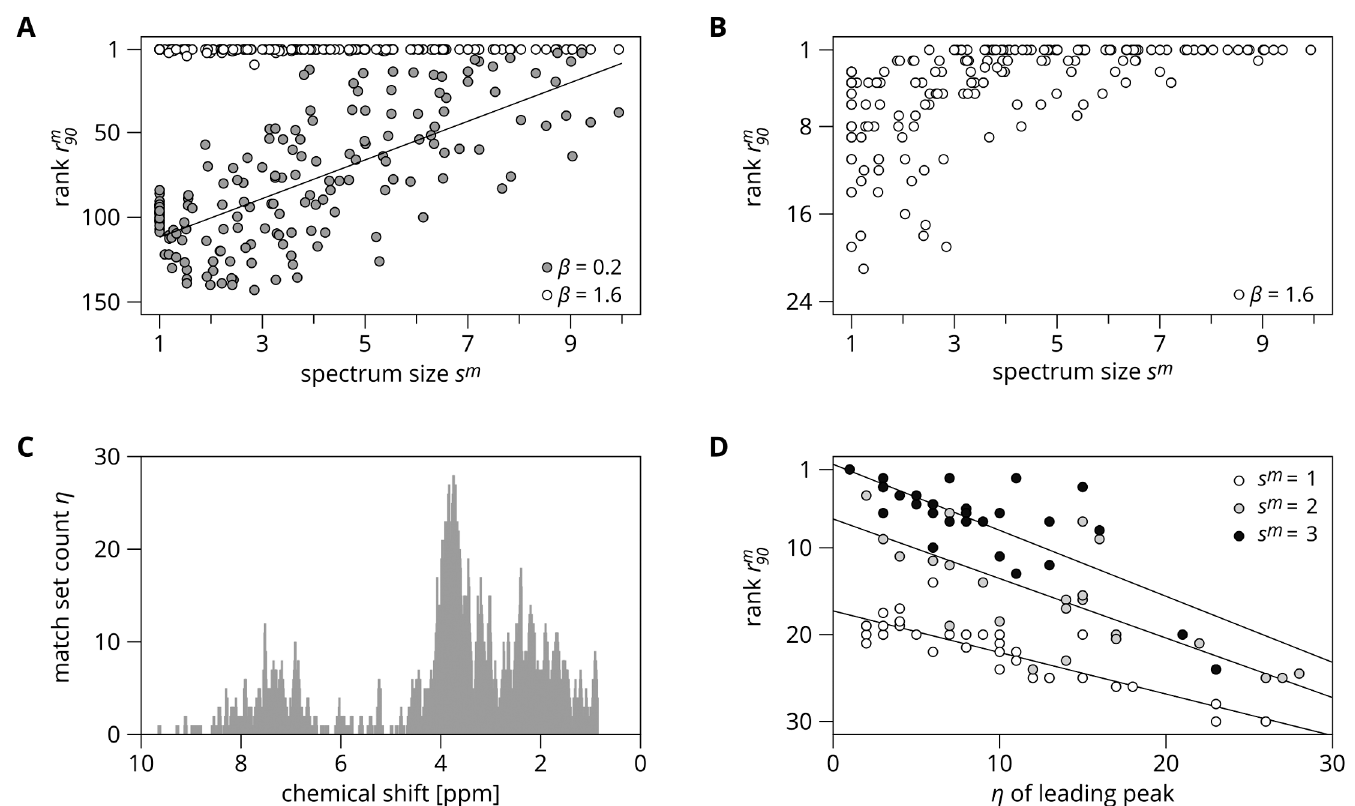
Fig 3. Metabomatching results on simulated metabolomes. A. Metabomatching performance, measuredas r m , the 90 th percentileof 1 000 ranks 90 obtainedfor m by metabomatching pseudospectra build from the associationwith M 0 , for β = 0.2 (filled dots) and β = 1.6 (empty dots), as a function of the size of the metabolitespectrum.For β = 0.2, the correlationbetween r m and s m is − 0.71, with p * 10 − 26 . B. As in ( A ), but for metabolome M α , with β = 1.6, 90 N a = 64 and α = 0.6. C. For UMDB and δ = 0.02, number of match sets ( η ) that containeach feature (uniform binningin 0.01 ppm increments). D. Metabomatching performance, measuredas r m , for M α , with β = 1.6, N a = 64 and α = 0.6, as a function of η of the leadingpeak of the metabolitespectrum, 90 that is the peak with h j = 1. Metabolitesizes are rounded.For s m = 1, 2, and 3, respectively,correlations ρ are 0.86, 0.79, and 0.76, with p -values * 10 − 10 , 10 − 4 , and 10 − 4 .